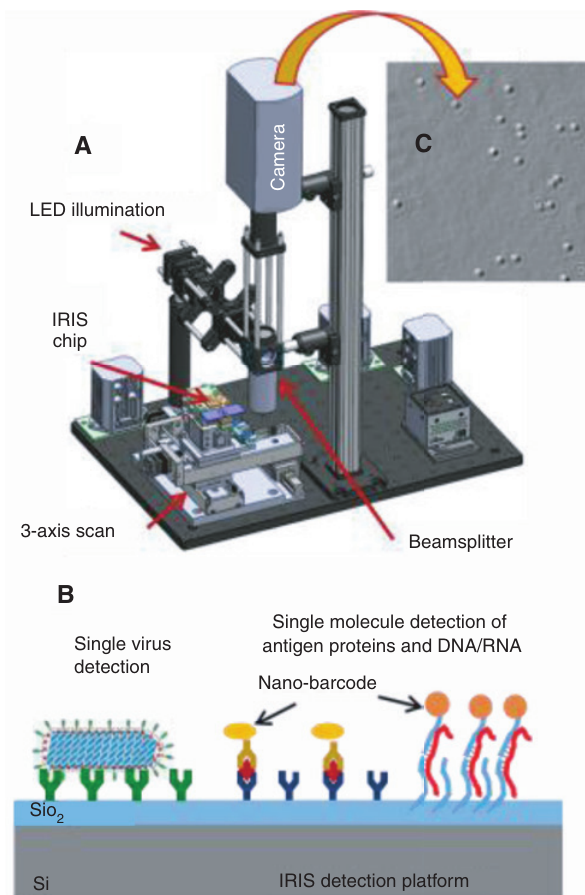
Figure 5: (A) The single particle interference reflectance imaging sensor (SP-IRIS) instrument layout and (B) schematic of substrate and surface coatings. Wide-field epi-illumination is reflected by the thin film substrate, and individual BNPs are detected as diffraction- limited perturbations to the reflected field. Beyond label-free detec- tion of individual BNPs, functionalized metallic nanoparticles may be used as single-molecule labels. Adapted from